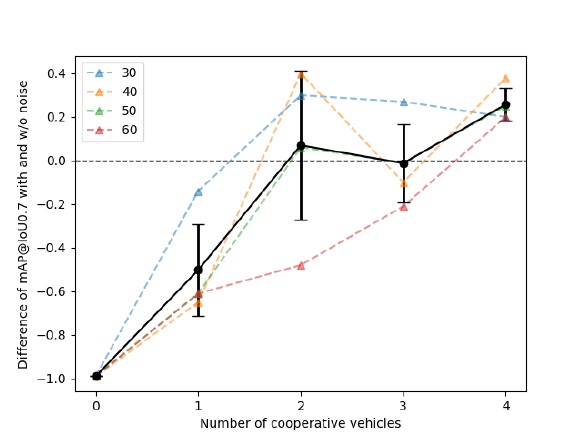
Figure 7. Influence of sensor noise on detection performance. Performance drop (mAP@IoU0.7 difference in %) of different communication ranges are plotted with the dashed line in differ- ent colors. The black solid line is the mean mAP drop of all results. Vertical bars indicate the standard